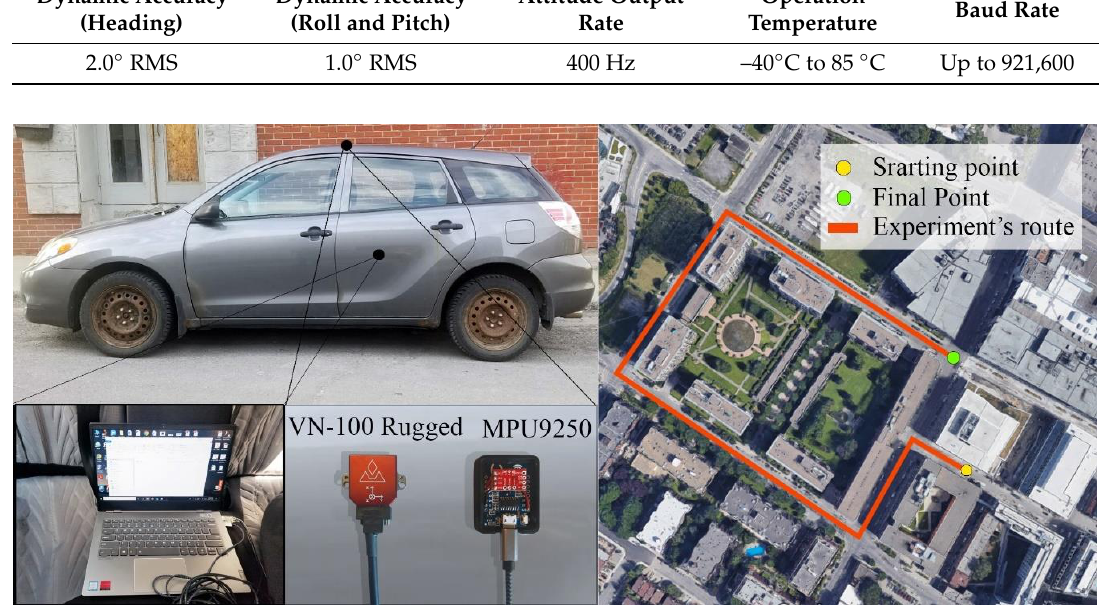
Figure 7. Dynamic experiment’s equipment and the experiment’s path. Table 4. Specification of the VN-100 Rugged AHRS board.